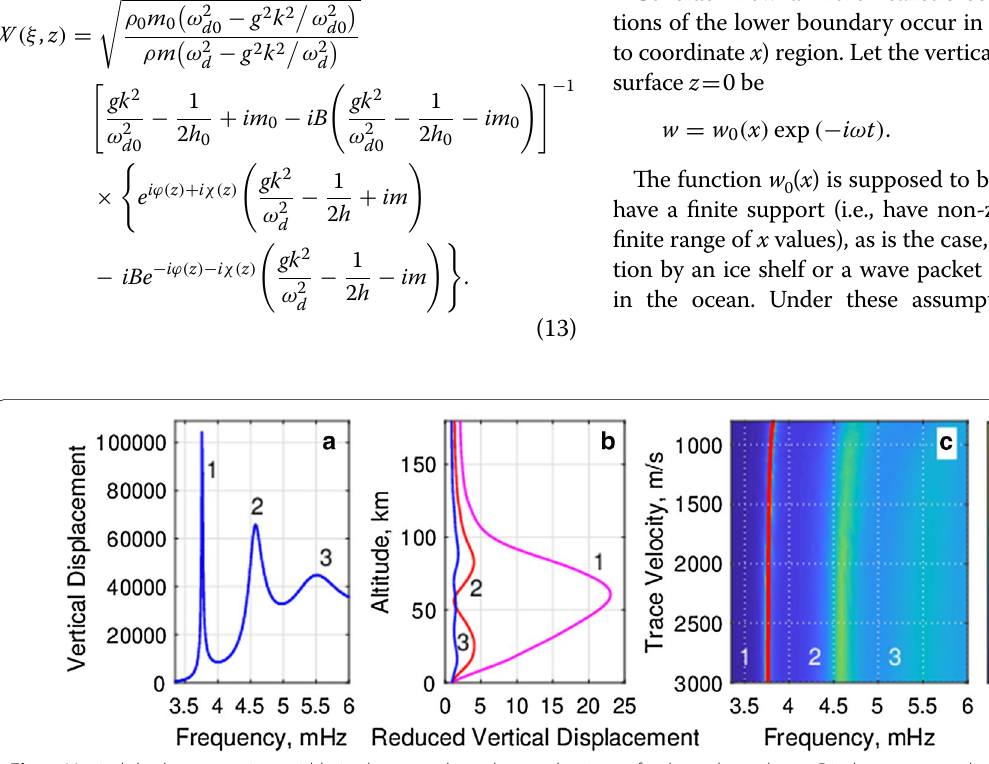
Fig. 1 Vertical displacements in a mid-latitude atmosphere due to vibrations of its lower boundary. a Displacement amplitude, | w |, at altitude z 180 km in a wave with trace velocity V 3000 m/s. Atmospheric resonances manifest as peaks of the displacement’s frequency dependence. b = = Variation with altitude of the amplitude of the reduced vertical displacement Q , Eq. (23), at frequencies of the first three atmospheric resonances. c Variation of the resonance frequency and quality factor of acoustic resonances with the trace velocity of excitation. Color shows displacement amplitude at z 180 km. The red line is the WKB predictions for the frequency of the first acoustic resonance and is obtained from Eq. (10). = Monochromatic ground-level displacements and summer conditions over Wallops Island (Virginia, USA) are assumed in all simulations. The displacement and reduced displacement amplitudes are normalized by their values at z 0 and are dimensionless. Resonance orders n 1, 2, 3 are = = indicated in all